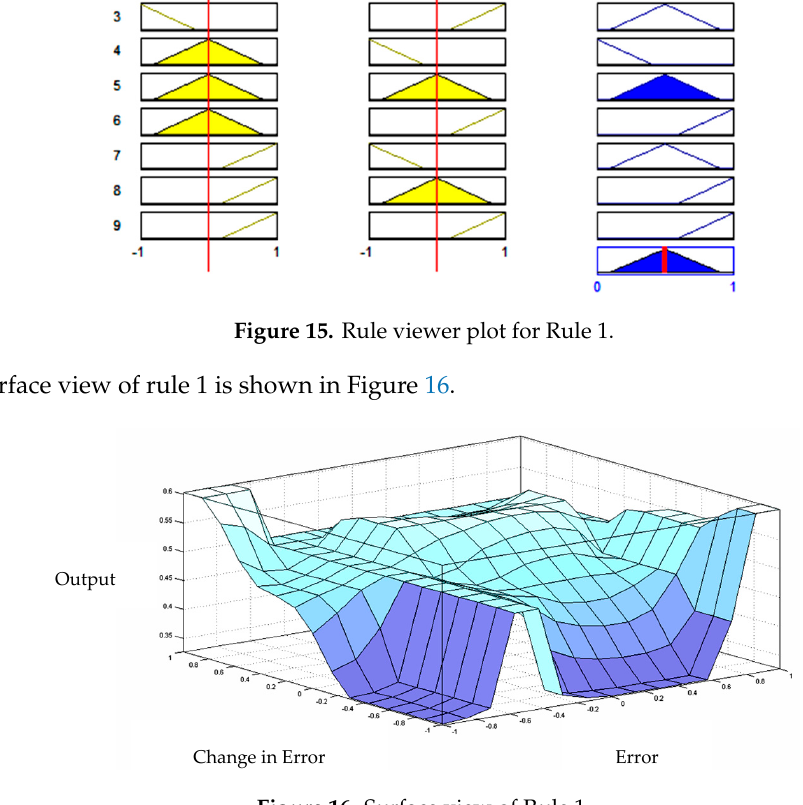
Figure 16. Surface view of Rule 1.